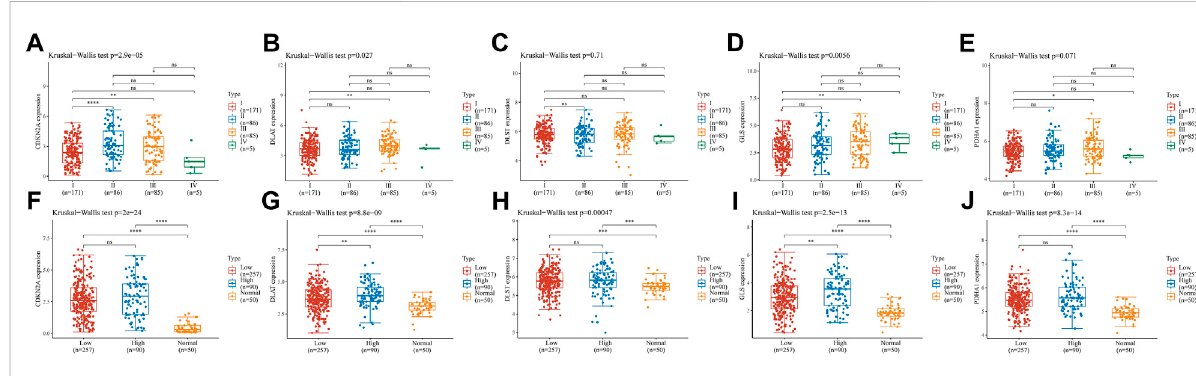
FIGURE 8 Risk model gene analysis (A – E) The expression of different pTNM between fi ve CRGs in HCC. CDKN2A (A) , DLAT (B) , DLST (C) , GLS (D) , and PDHA1 (E) (F – J) The expression of low and high tumor-grades and adjacent normal tissues between fi veCRGs in HCC. CDKN2A (F) , DLAT (G) , DLST (H) , GLS (I) , and PDHA1 (J) .